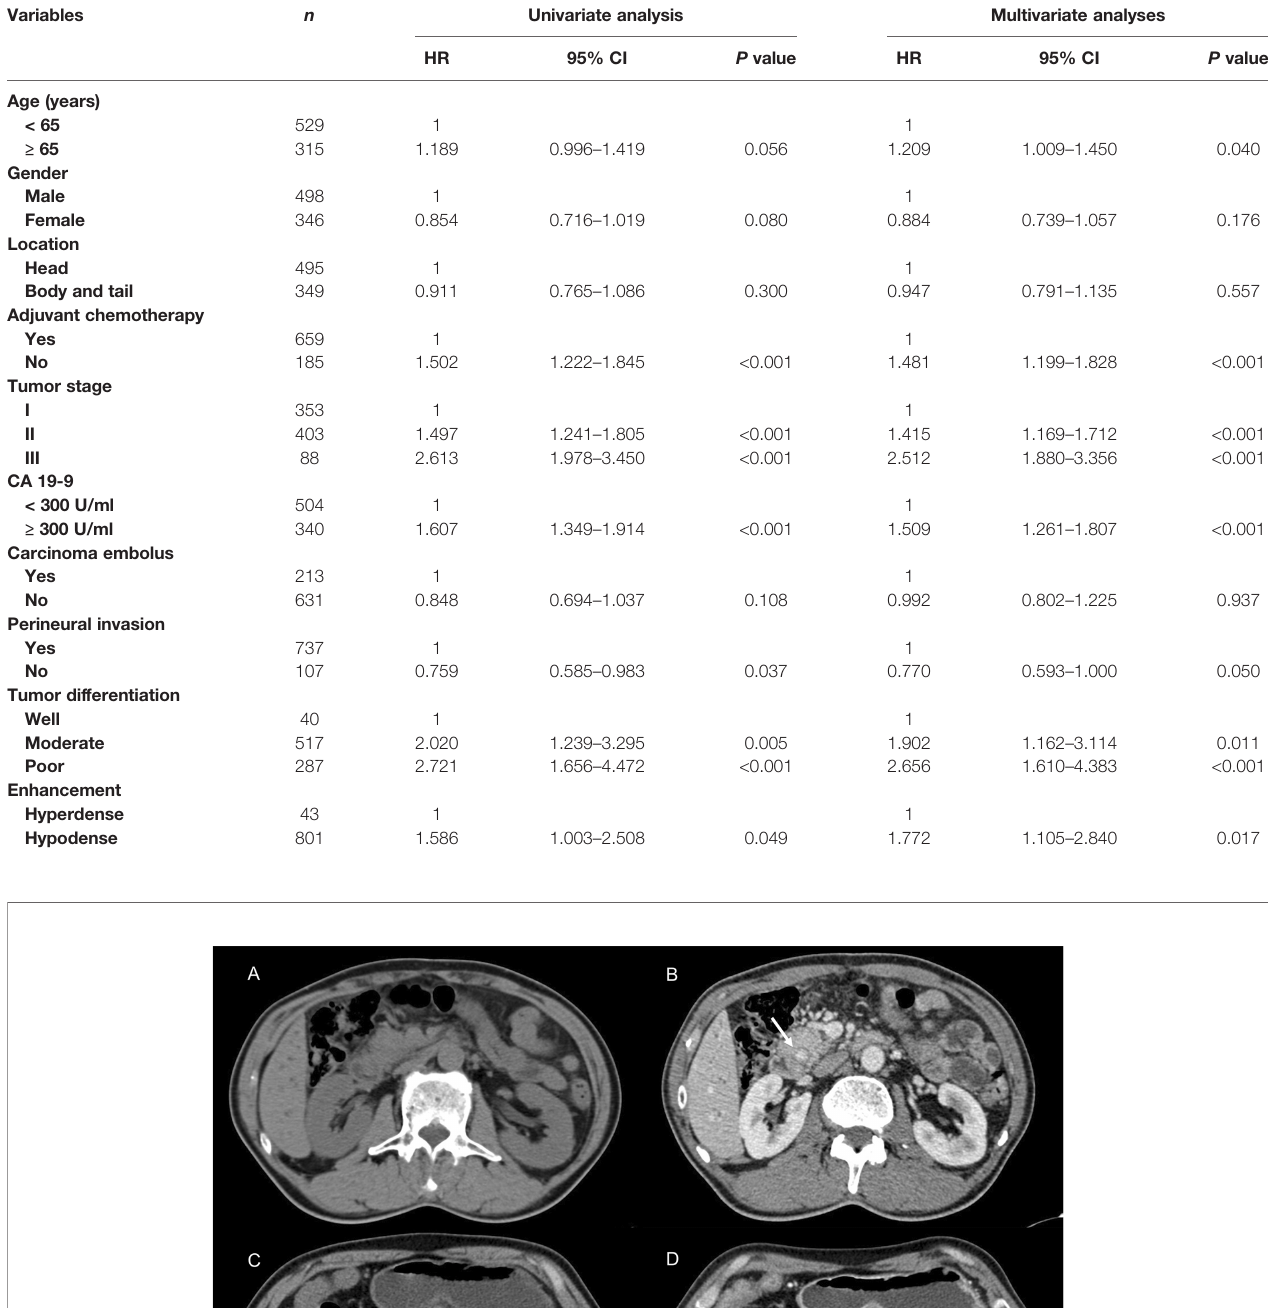
TABLE 3 | Univariate and multivariate analyses for the OS.